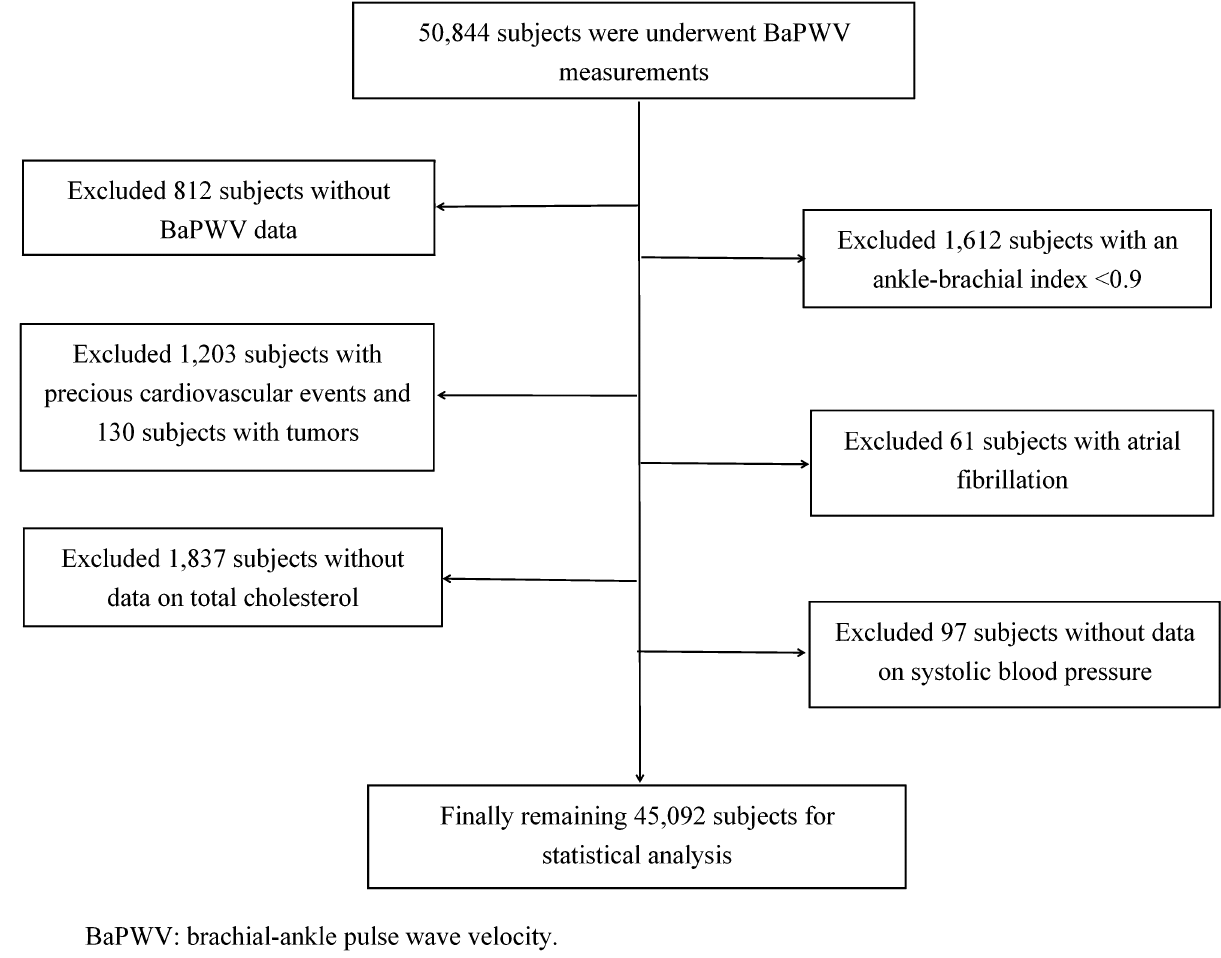
Figure 1. Inclusion/exclusion flowchart for study